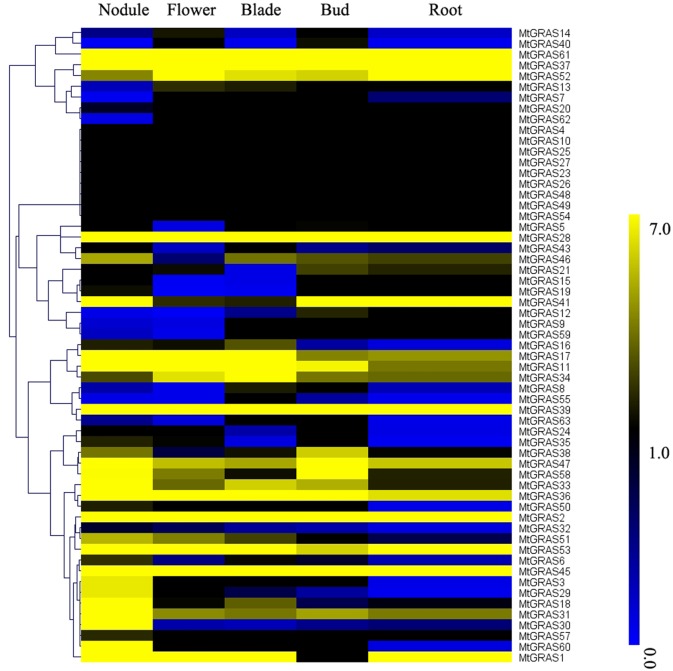
Expression profile cluster analysis of MtGRAS genes.